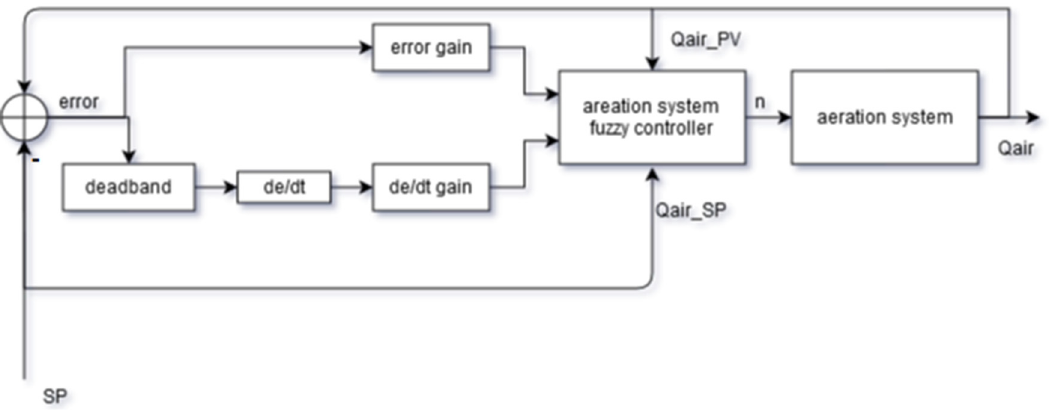
Figure 10. The final structure of the fuzzy controller.